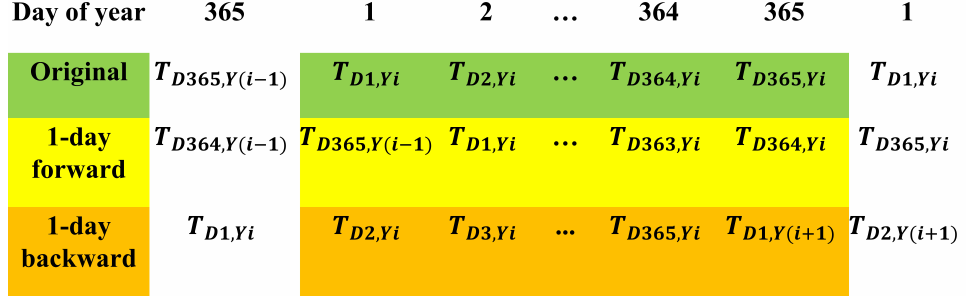
Figure 3. Shifted dates method to generate extra temperature scenarios.